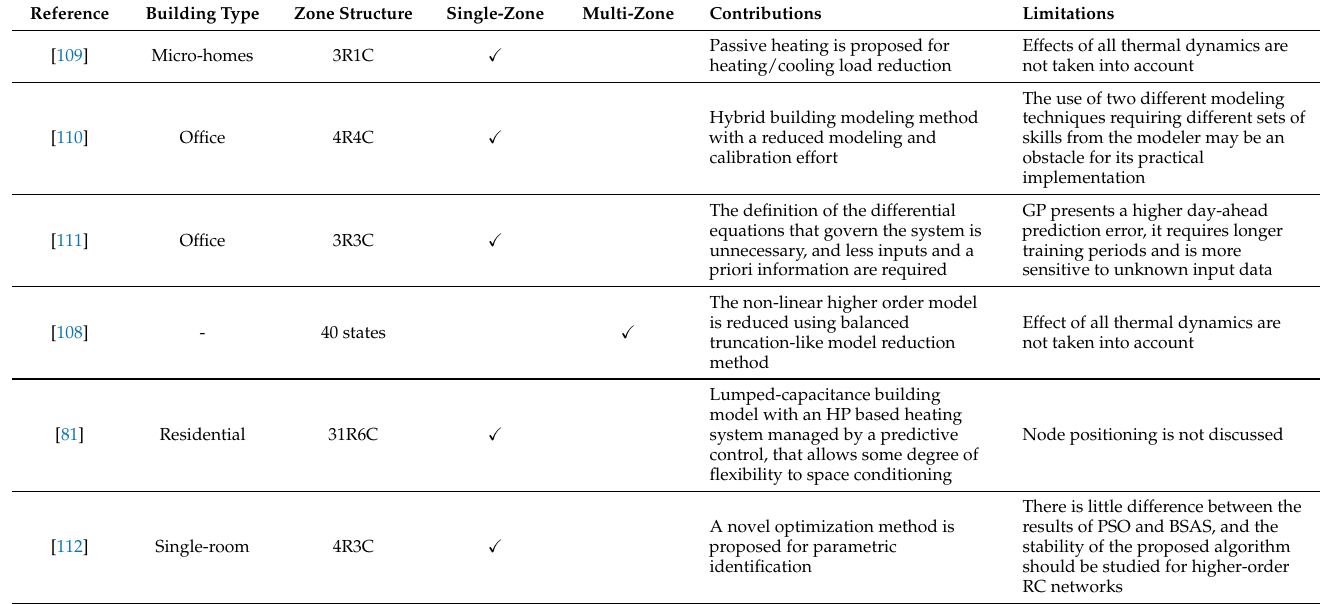
Table 5. Analysis of whole-zone models based on the thermal network